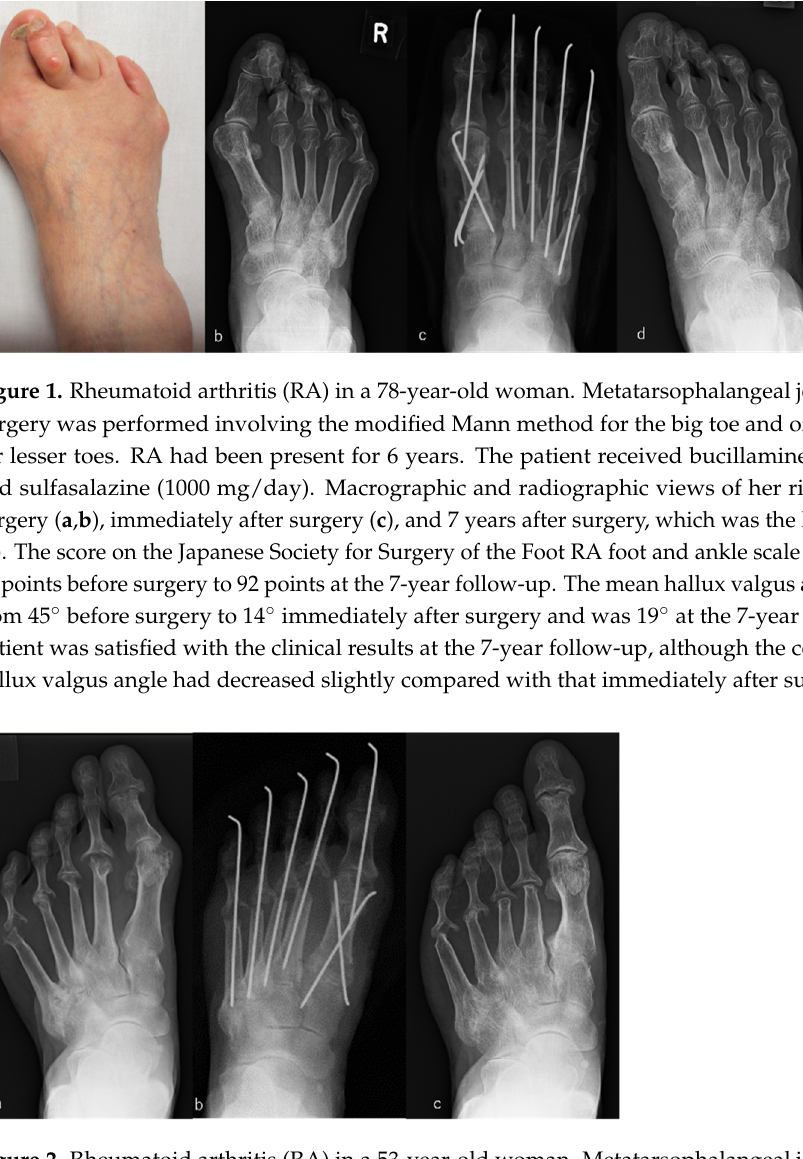
Figure 2. Rheumatoid arthritis (RA) in a 53-year-old woman. Metatarsophalangeal joint-preserving surgery involving the modified Mann method was performed for the big toe, and resection arthro- plasty was performed for lesser toes. RA had been present for 29 years. The patient received methotrexate (4 mg/week), tacrolimus (2 mg/day), and sulfasalazine (1000 mg/day). Radiographic views of her left foot before surgery ( a ), immediately after surgery ( b ), and 8 years after surgery, which was the latest follow-up ( c ). Scores on the Japanese Society for Surgery of the Foot RA foot and ankle scale improved from 50 points before surgery to 84 points at the 8-year follow-up. The mean hallux valgus angle improved from 32° before surgery to 9° immediately after surgery and was 16° at the 8-year follow-up. The patient was satisfied with the clinical results at the 8-year follow-up, although the correction of the hallux valgus angle had decreased slightly and the metatarsal bone had short- ened compared with the values immediately after surgery.